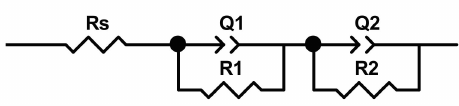
Figure 6. Equivalent circuit used to model EIS spectra of titanium oxide nanotubes sample [31].